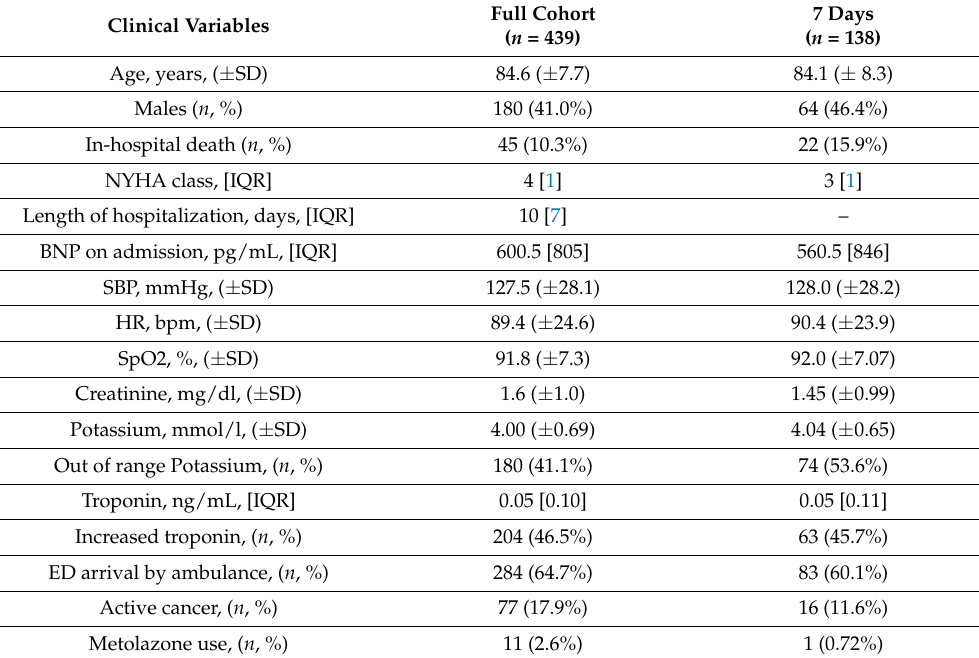
Table 2. Baseline characteristics of the